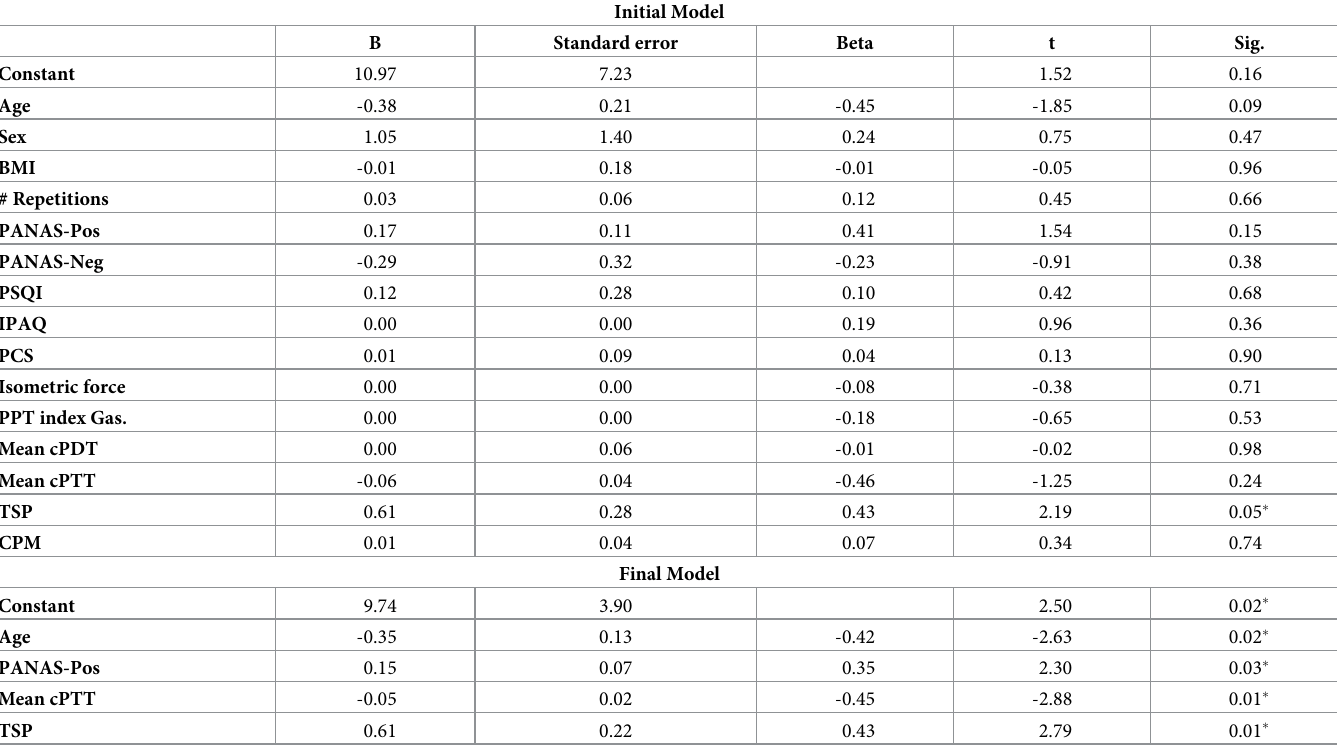
Table 3. Initial and final linear regression model statistics for prediction of Day-2 pain